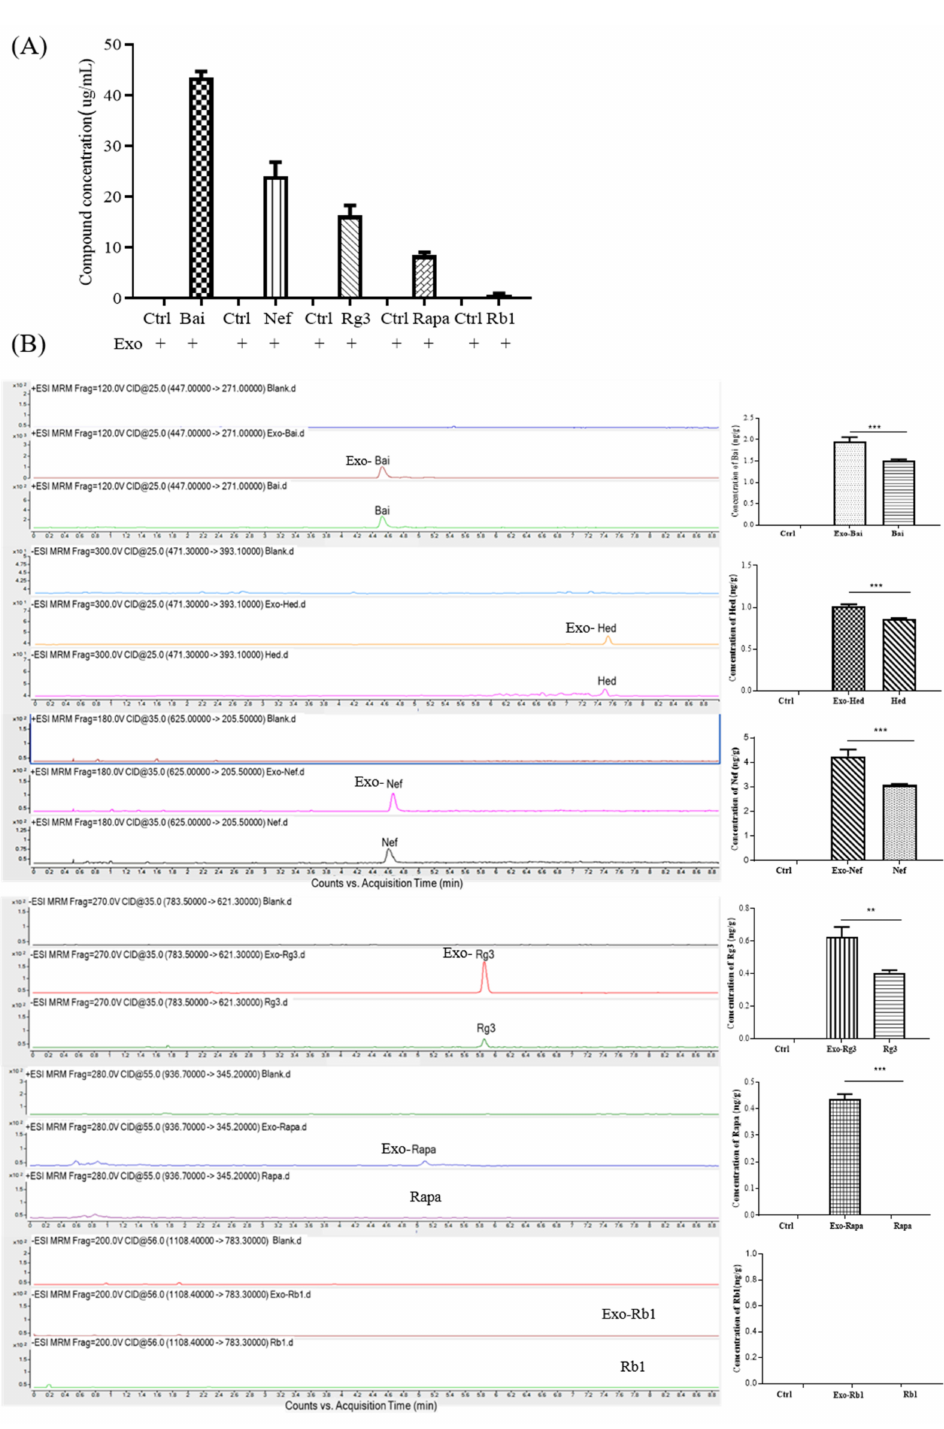
Figure 3. BBB permeability of exosome-encapsulated herbal compounds with increasing molecular weights. ( A ) The compound concentrations of Bai, Nef, Rg3, Rapa and Rb1 were determined by UHPLC-MS after the exosome encapsulation. ( B ) The concentration of the herbal compounds in the brain tissue (ng/g) after the i.v. injection of Exo-compounds (the concentrations of Exo-Bai, Exo-Hed, Exo-Nef, Exo-Rg3, Exo-Rapa and Exo-Rb1 were 100 µ g/kg) were determined by UHPLC-MS. PBS was applied in the control group. All of the experiments were performed as three independent experiments. One-way ANOVA was used to compare the data: ** p < 0.01, *** p <